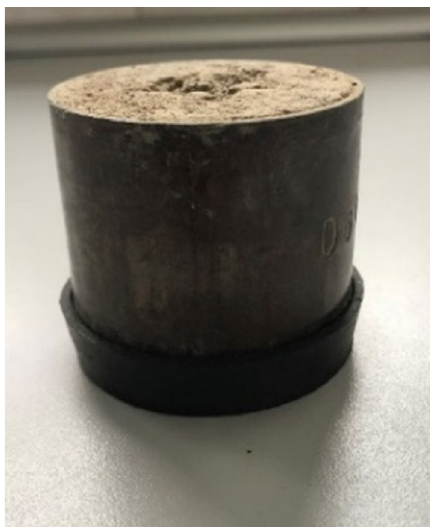
Figure 1. The example of sample collected from the experimental field and prepared for measurements within the small accumulation chamber in the process of radon emanation assessment.